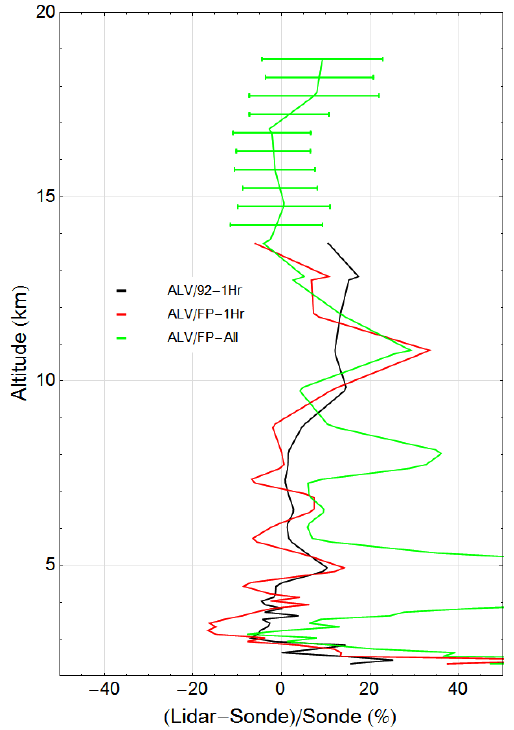
Fig. 3. Mean normalized differences of all available 1h and all-night Fig.3. Meannormalizeddifferencesofallavailable1-handallnightsumALVICEprofileswithRS92andFP. Thestandarddeviationofthedifferencesisplottedabove14kmfortheFPallnightlidarcomparison. Seetext sum ALVICE profiles with RS92 and FP. The standard deviation fordetails. of the differences is plotted above 14km for the FP all-night lidar comparison. See text for